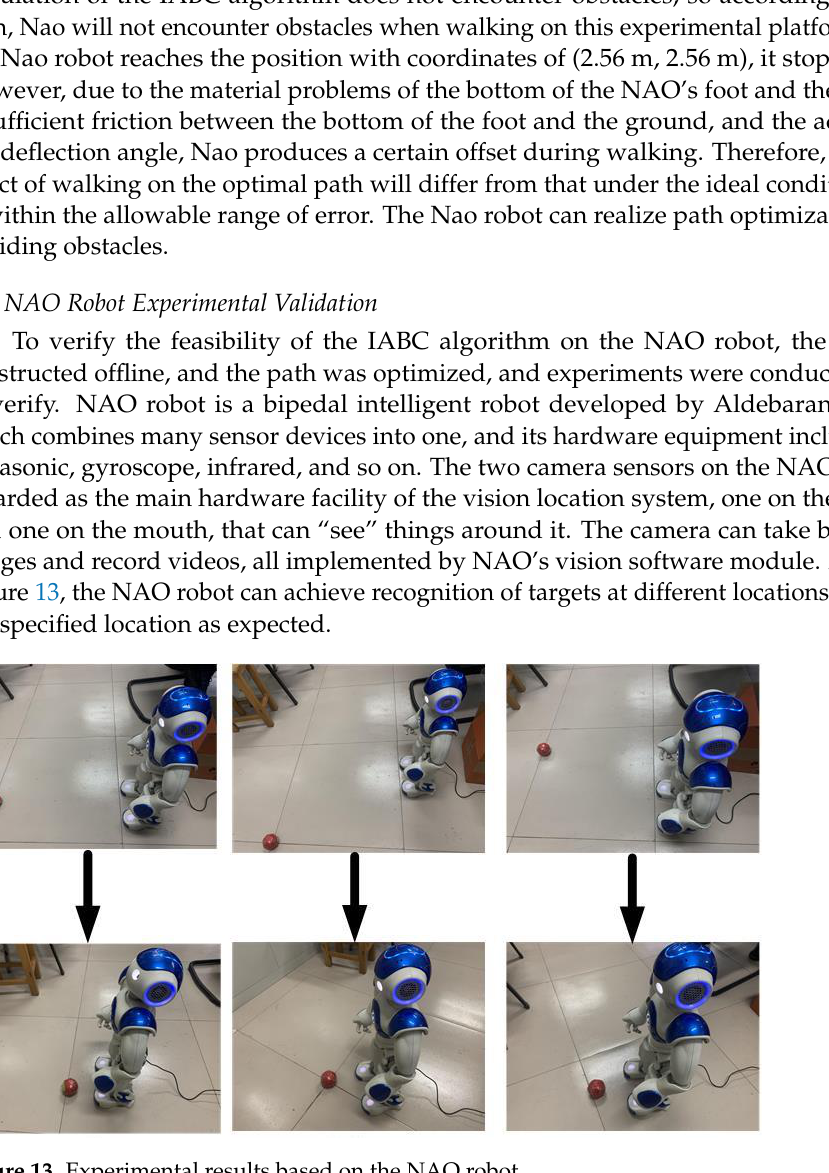
Figure 12. Verification results of optimal path.